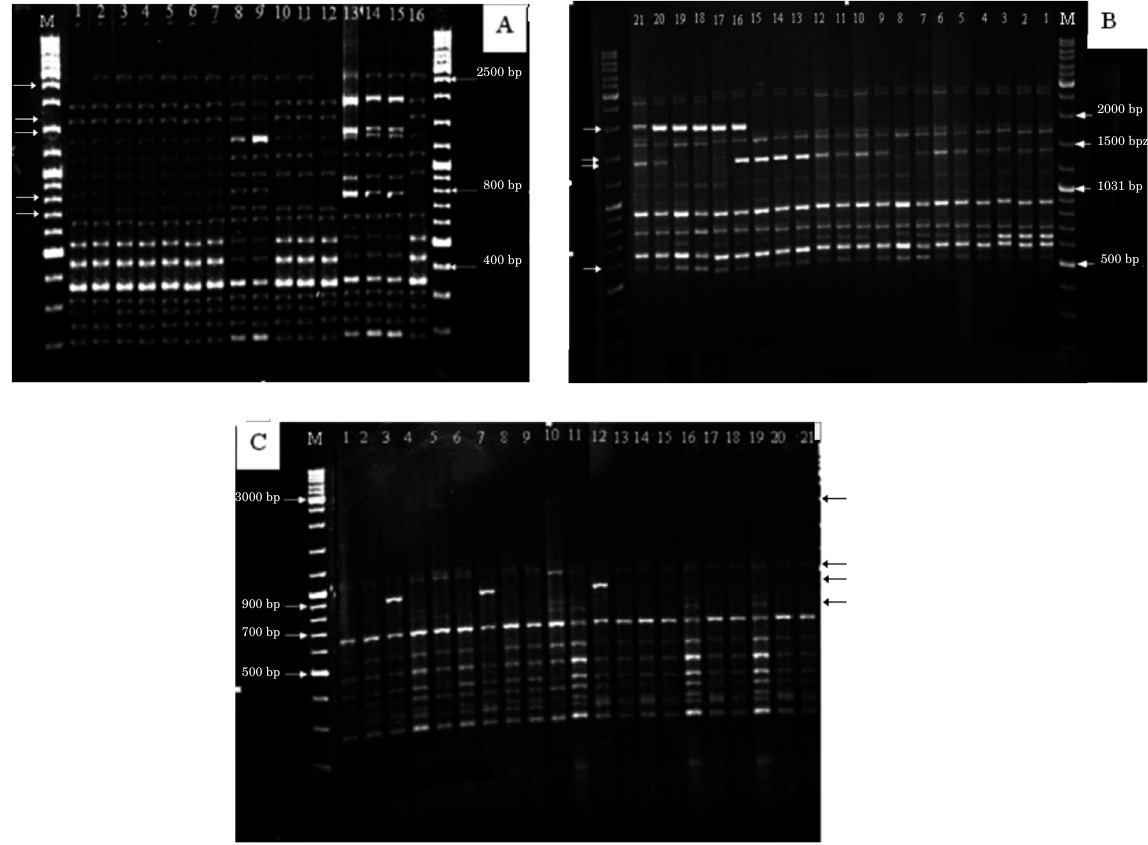
Figure 2. rep-PCR fingerprint patterns of Pcc strains isolated from different